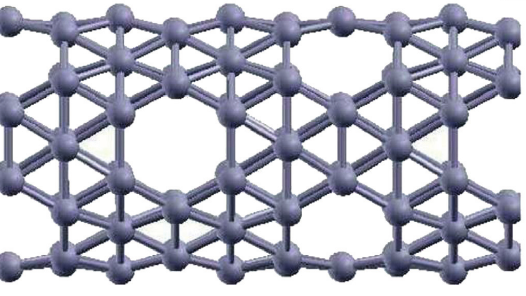
Figure 2: Boron α -nanotube ( B Table 2: Vertex partition of boron α -nanotube ( B